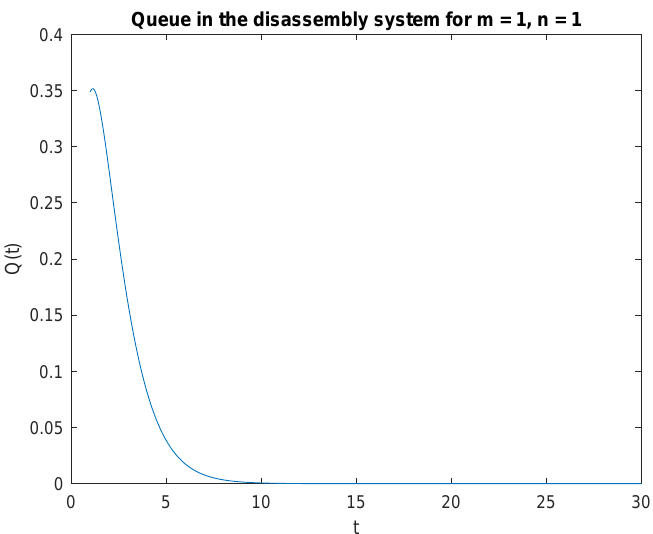
Figure 4. Impact of buffer state on probability P { X ( t ) = 1 | X ( 0 ) = 1 } .